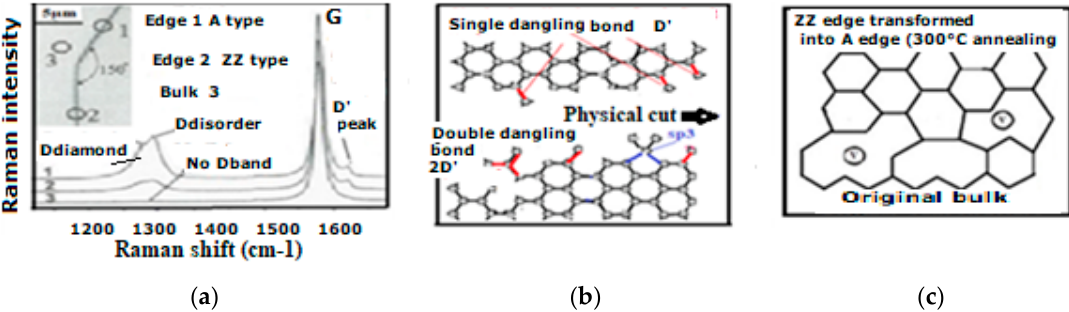
Figure 12. Graphene edge analysis of cut graphene plane and scheme of edge modification. ( a ) Raman spectra of cut graphene by Cançado et al. [222] by permission of the Physics Review Letters. D (1333 cm − 1 ), D disorder peaks: GeA (~1350 cm − 1 ) and D’ disorder Csp2-Csp2 (~1620 cm − 1 ) are shown. Sharp G peak means that no disorder exists on hexagonal sp2 rings. ( b ) Our proposed scheme of graphene cut edge with the formation of sp3, single and double dangling Csp2-Csp2 corresponding to D diam, D’ and 2D’ peaks. ( c ) Our proposed scheme of voids formation associated to the thermally induced ZZ edge transformation into the A edge with internal ZZ and A edges on formed voids.